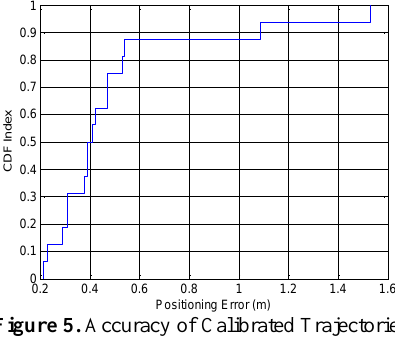
Figure 5. Accuracy of Calibrated Trajectories